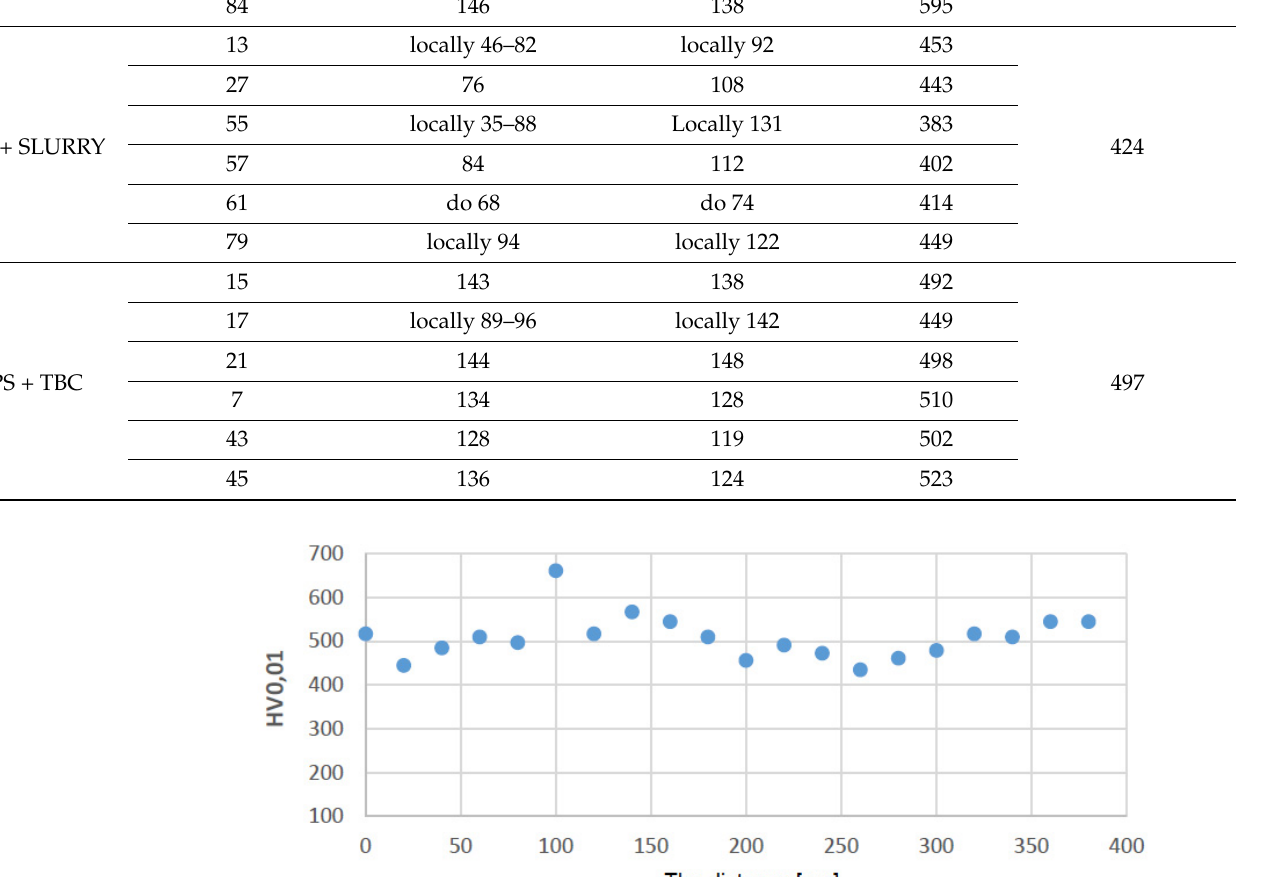
Figure 11. Distribution of microhardness on the leading edge for the protective coating made using the APS + VPA method. Figure 12. Distribution of microhardness on the leading edge for the protective coating made using the APS + SLURRY method.